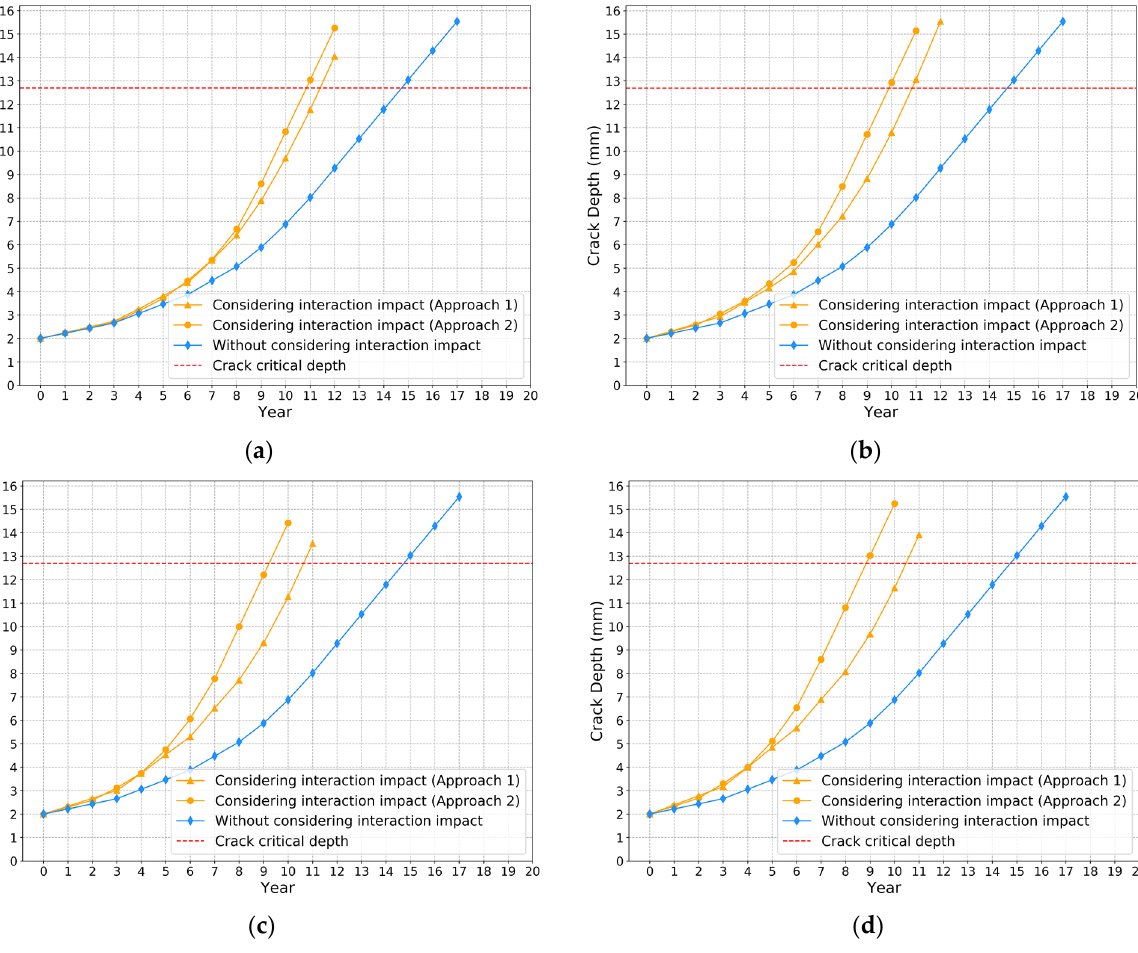
Figure 15. Investigations of the interaction impact on crack depth growth. Corrosion initial depth: